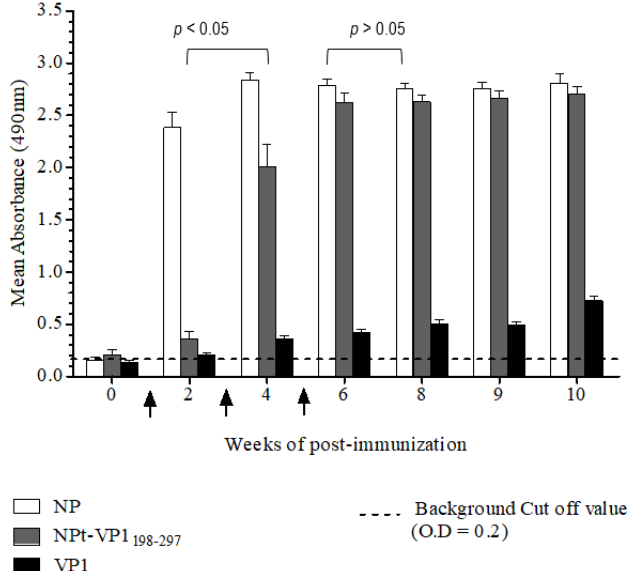
Figure 9. Determination of total IgG titers of anti-NP in the immunized sera by ELISA. Immunization time-points were indicated by arrows and the cut-off value was indicated by broken lines. The anti-VP1 IgG titers for NPt-VP1 197–297 (n = 8) significantly increased ( p < 0.05) after primary immunization and was further enhanced by every booster injection when compared to the VP1.